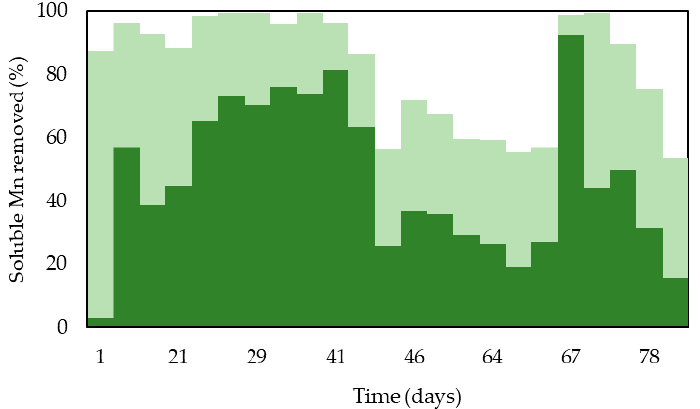
Figure 4. Manganese removed in effluent liquors from the two connected MnOB columns used in phase C3. Key: water draining column 1 (dark green) and water draining column 2 (light green). Yeast extract was added on day 66 (final concentration 100 mg L − 1 ). Table 2. Concentrations of dissolved organic carbon (DOC; mg L − 1 ) in influent and effluent liquors from the sulfidogenic bioreactor and the effluent liquors from the MnOB as mean values and standard deviations (n = 5).